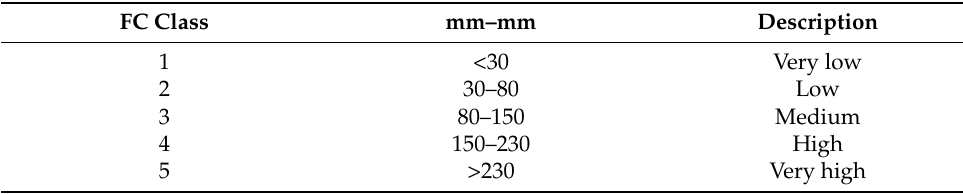
Table 3. Classes of soil’s effective field capacity (FC) used in the soil map of Slovenia.